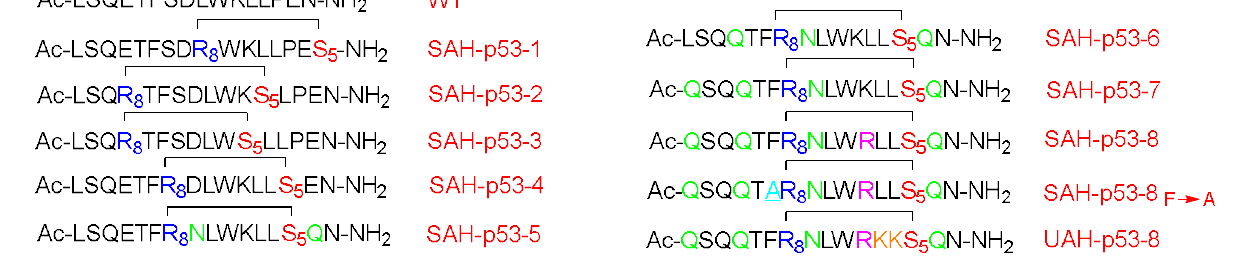
17 of 34 Figure 9. BID-BH3 parent peptide and the corresponding five analogs with different stapling posi- tions. Nor: Norleucine. Fmoc-R 5 -OH (Fmoc-(R)-2-(4-pentenyl)Ala-OH) and Fmoc-S 8 -OH (Fmoc-(S)- 2-(7-octenyl)Ala-OH) are shown at the right in pink and green, respectively. For S 5 refer to the leg- end of Figure 6. Interestingly, it showed high helicity, protease resistance, cell penetration ability, and a high binding affinity towards BCL-2. This peptide can activate the apoptotic pathway to kill leukemia cells and inhibit the growth of human leukemia xenografts. Helicity is im- portant in the protein–protein interactions (PPI) and may either stabilize or to interrupt